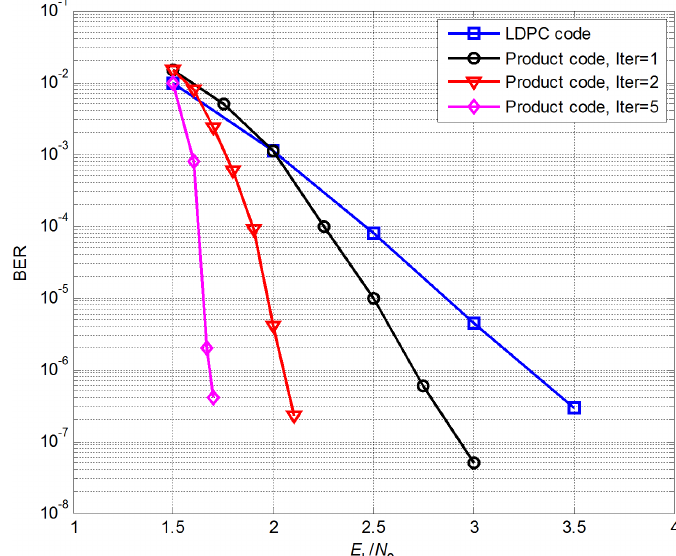
Figure 6. Iterative decoding performance of the product code with LDPC (576, 288) and Hamming (255, 247).